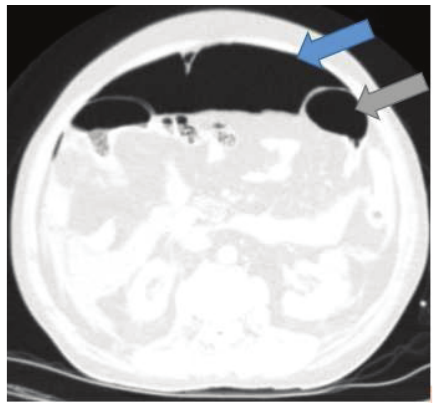
Figure 2: Massive pneumoperitoneum (with blue arrow) and normal intraluminal intestinal air density (with grey